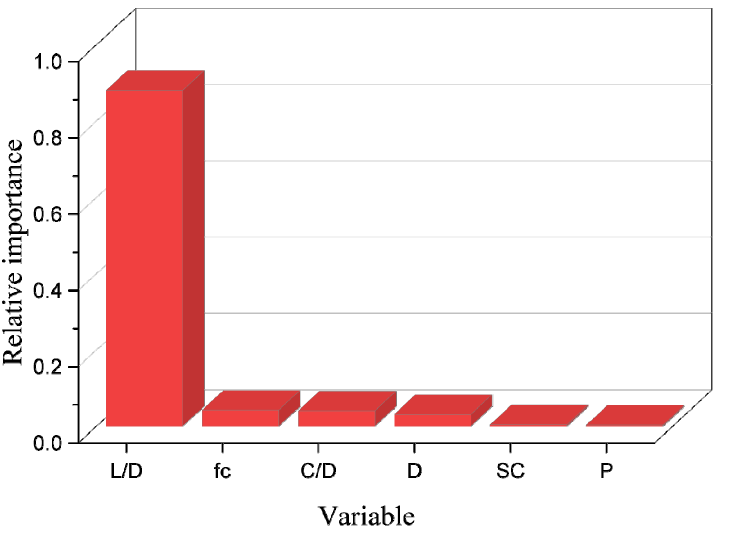
Figure 8. The relative importance of input variables to output bond strength.